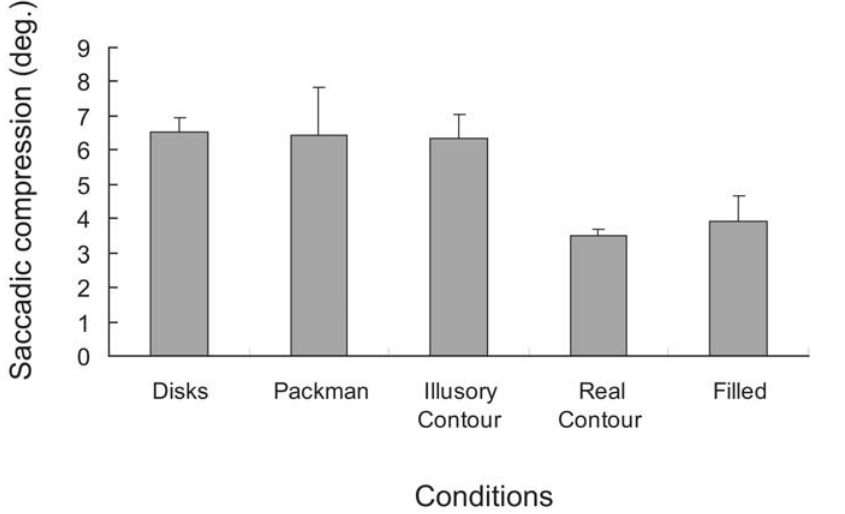
Figure 1. Averaged magnitude of horizontal saccadic compression for participants in Sogo and Osaka’s Experiment 1. Bars indicated the averaged magnitude of the saccadic compression for all conditions: Disks, Packman, Illusory contour, Real contour, and Filled figures. Error bars indicated standard deviation of the compression among their three participants. The figure highlights that Sogo and Osaka observed substantial horizontal saccadic compression even for the control figures: the real contour and filled contour conditions.